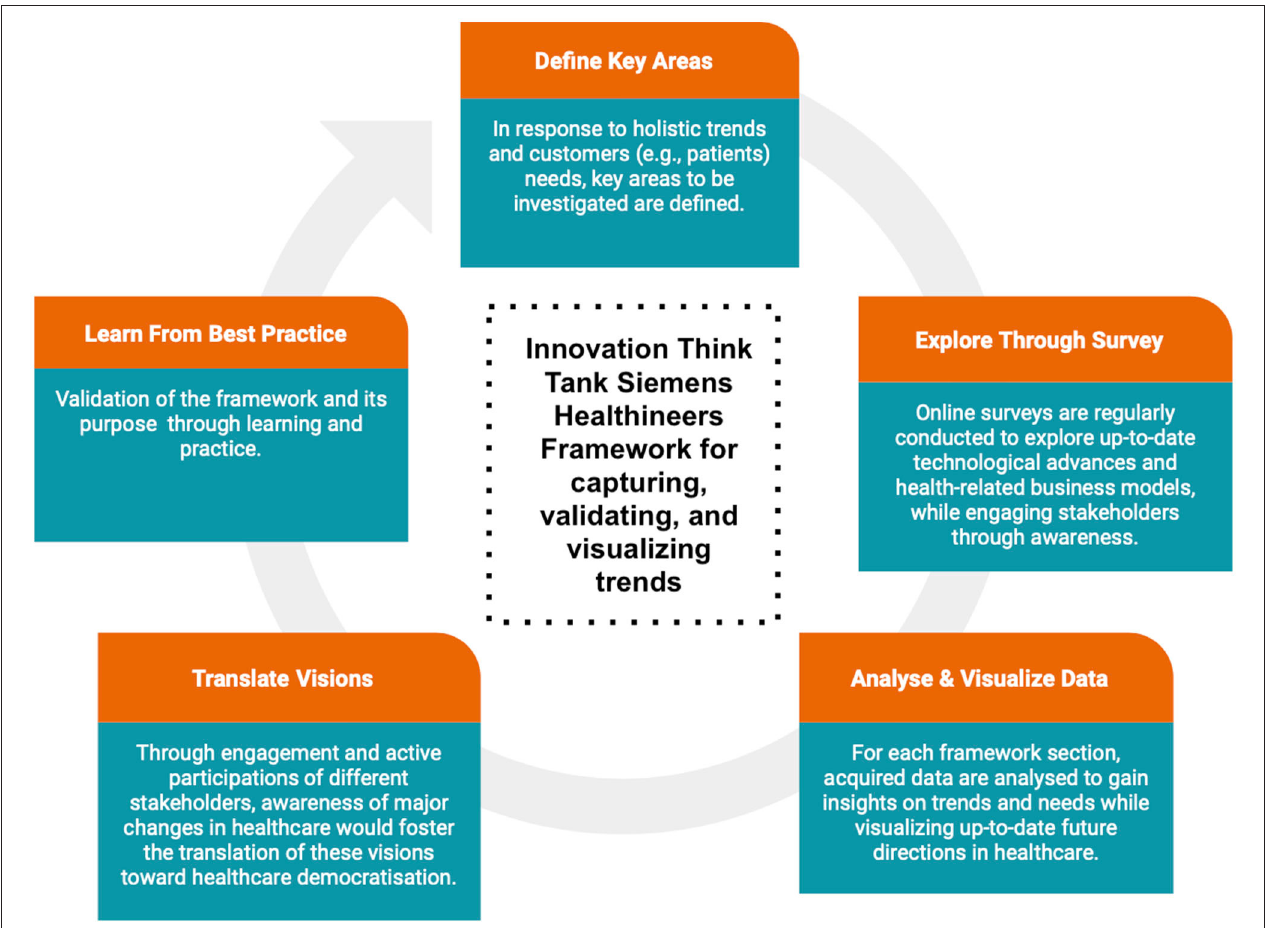
FIGURE 1 | Innovation Think Tank Framework for capturing, validating and visualizing trends. In the first phase, areas to be further investigated are identified. This phase concerns the detection of future holistic trends and customers’ needs. In the second phase, online surveys are regularly conducted to explore up-to-date advances regarding medical technologies and health-related business models to promote novel value propositions. In this phase, stakeholders are engaged through awareness and proactive participation. The third phase concerns the analysis and visualization of collected data. Thus, the investigation of data would allow insight into future trends and needs based on which healthcare should focus. In the fourth phase, future visions are translated into actions, in which different stakeholders are engaged toward the promotion of change and healthcare democratization. Lastly, in the fifth phase, the developed framework and methodology are constantly evaluated and validated based on learning and